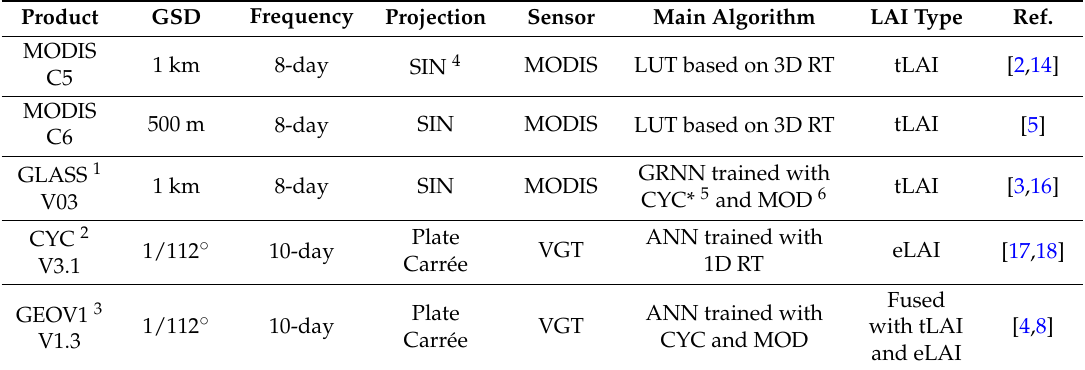
Table 1. Global LAI/FPAR products investigated in this study. GSD, LUT, RT, GRNN, ANN, tLAI and eLAI stand for “Ground Sampling Distance”, “Look-Up Table”, “Radiative Transfer”, “General Regression Neural Network”, “Artificial Neural Network”, “true LAI” and “effective LAI”, respectively. Sensor Main Algorithm LAI Type